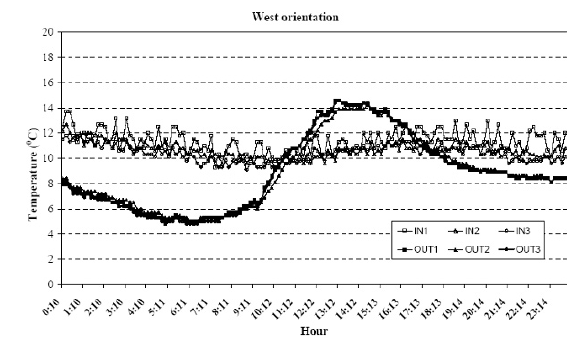
Figure 5. Temperature distribution inside and outside at north wall Winter period .